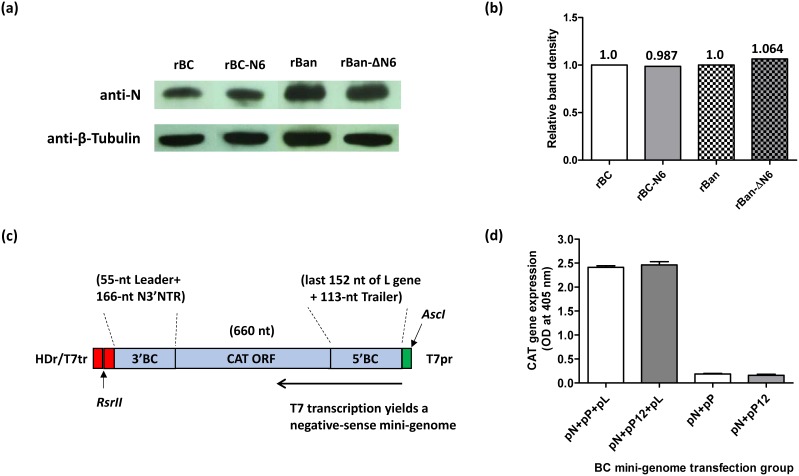
Comparative analysis of nucleocapsid protein expression and phosphoprotein function.(a) Nucleocapsid protein expression in DF-1 cells infected with rBC and rBC-N6 and rBan and rBan-ΔN6. Replicate cell monolayers were infected with rBC and rBC-N6 and rBan and rBan-ΔN6 at an MOI of 0.1, and were harvested at 24 h post-infection. Cell lysates were prepared and analyzed by polyacrylamide gel electrophoresis and immunoblotting with a polyclonal serum against a peptide prepared from the sequence of the N protein. β-Tubulin was used as the loading control. (b) The density of the N protein bands at 24 h was quantified to compare the N protein expression between parental viruses rBC and rBan to their respective N6 and ΔN6 mutant viruses using ImageJ program [28]. Note the similarity between the band densities of rBC and BC-N6 and rBan and rBan-ΔN6. (c) Map of the cDNA encoding the BC minigenome, which consisted of the first 166 nt from the leader end of the BC genome, followed by the CAT ORF, followed by the last 152 nt of the trailer end of the BC genome. (d) Analysis of mini-genome activity in lysates from transfected cells using an ELISA for the CAT protein to compare the activities of the wt and P12 versions of the P protein of strain BC. The N+P and N+P12 transfections are negative controls. CAT expression was expressed as absorbance at 405 nm.